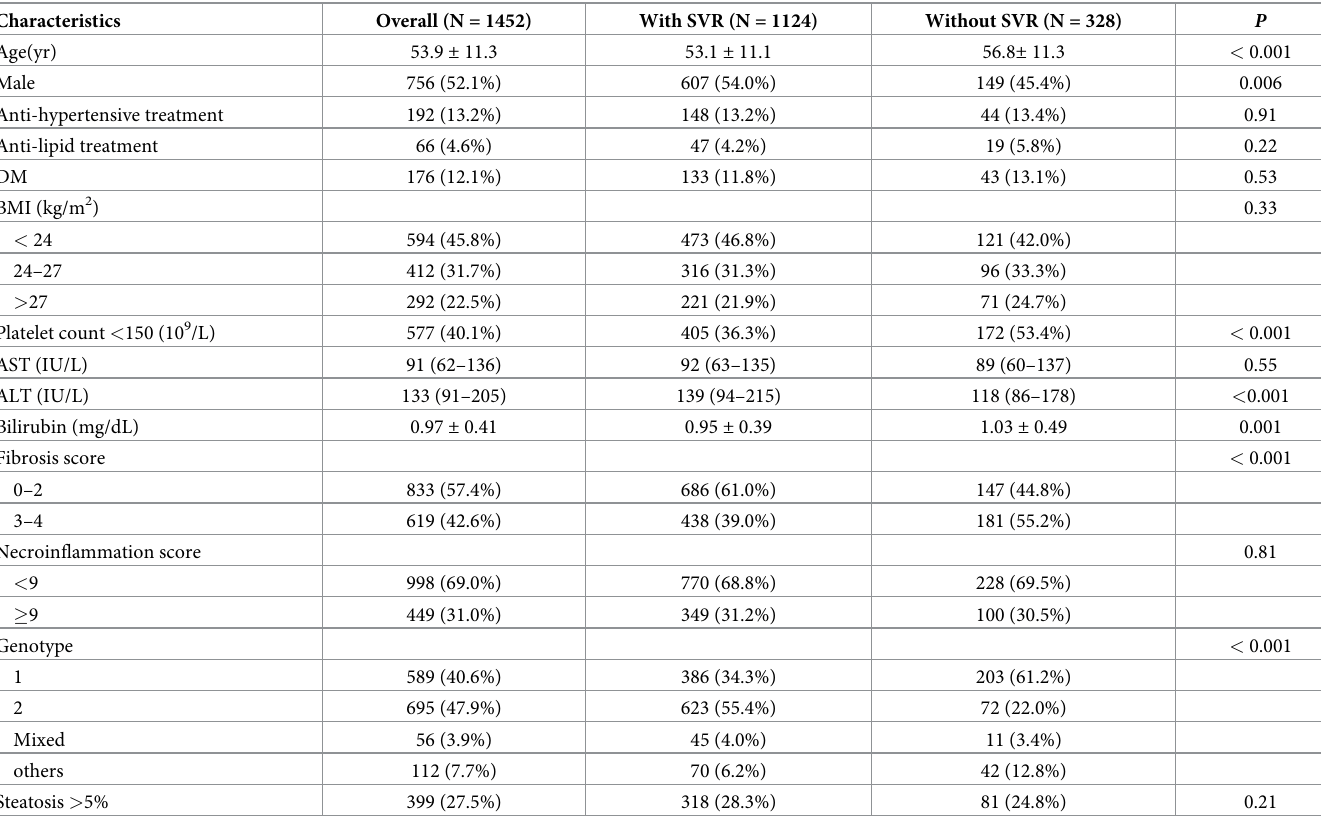
Table 1. Baseline Characteristics According to Treatment Response in all